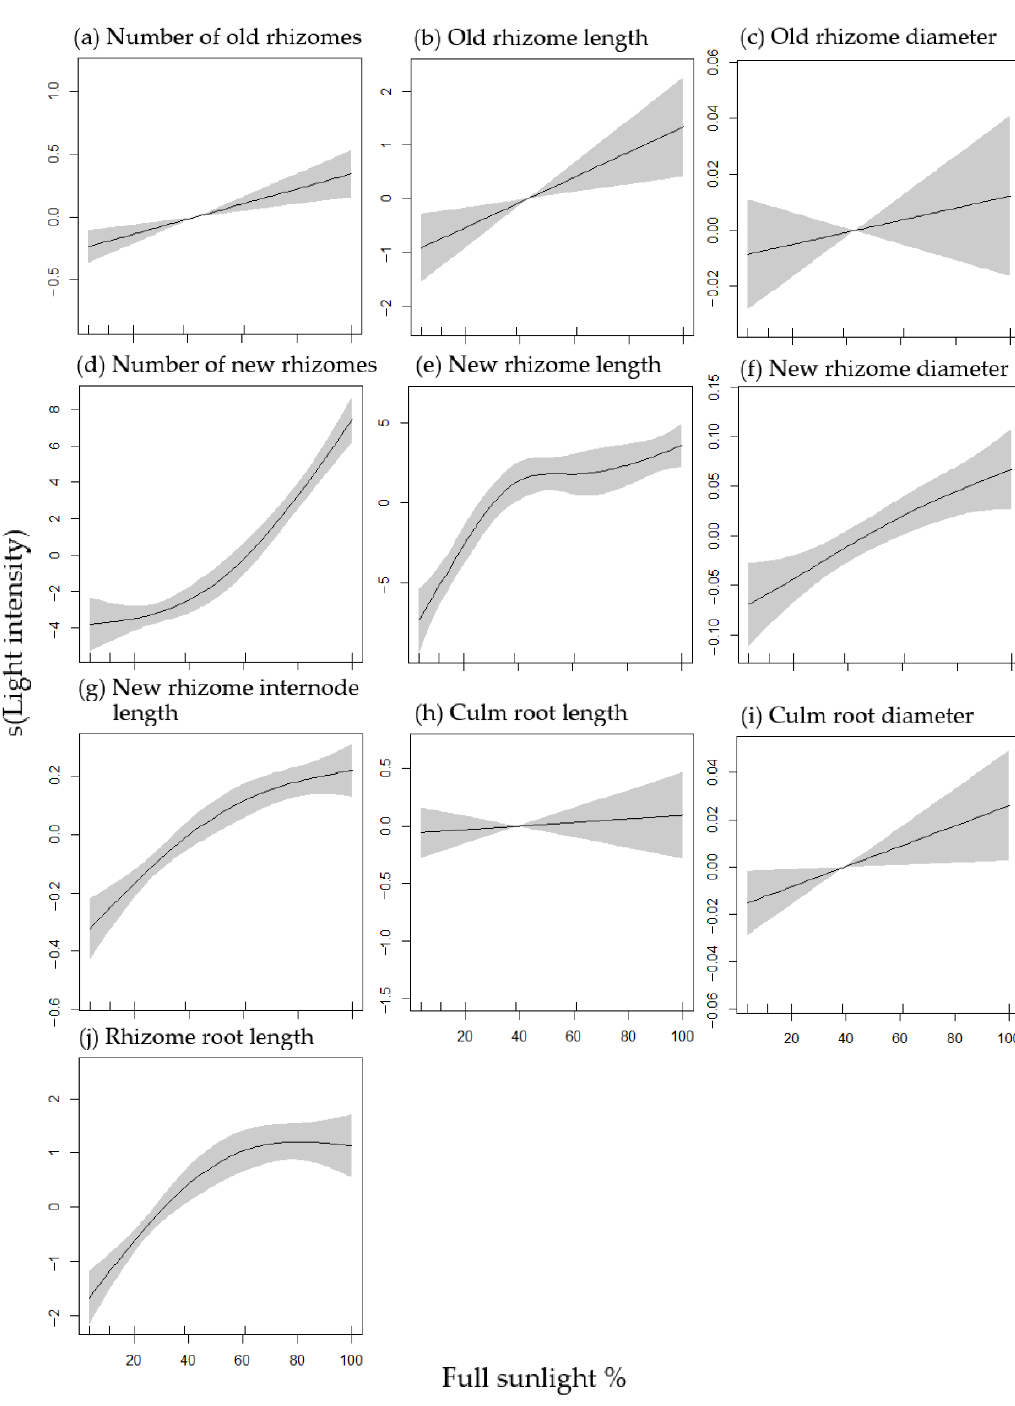
Figure 3. The plots of the GAMs’ smooth function for indicating the effects of light intensity on the number of old rhizomes ( a ), old rhizome length ( b ), old rhizome diameter ( c ), number of new rhizomes ( d ), new rhizome length ( e ), new rhizome diameter ( f ), new rhizome internode length ( g ), culm root length ( h ), culm root diameter ( i ) and rhizome root length ( j ). The grey ribbon shadow indicates the 95% confidence intervals of the fitted smoothers.